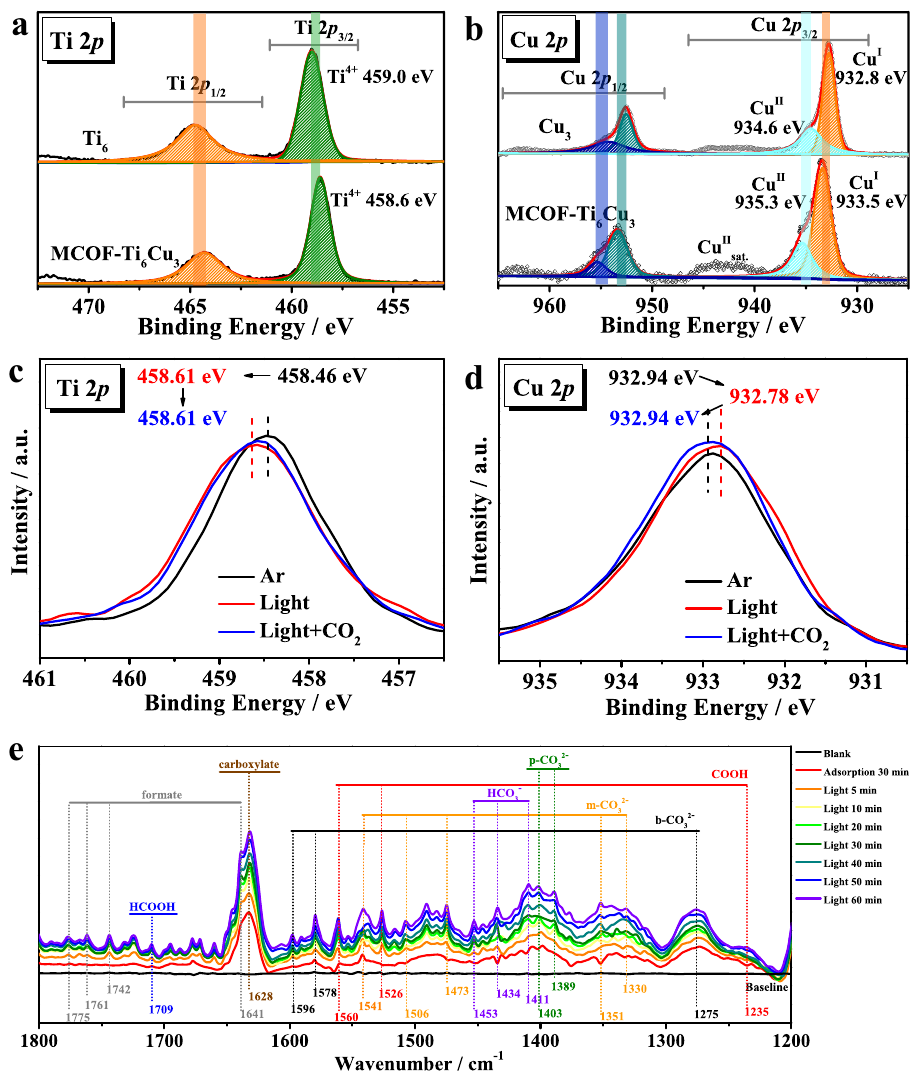
Fig.4|XPSandIn-situmeasurements. XPSspectrafor a Ti2 p ofMCOF-Ti 6 Cu 3 , Ti 6 and b Cu2 p ofMCOF-Ti 6 Cu 3 , Cu 3 .In-situXPSspectraof c Ti2 p and d Cu2 p forthe